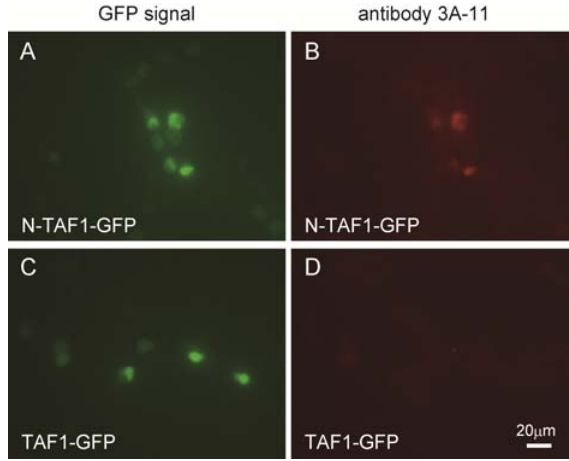
Figure 1. Immunocytochemistry of cultured Human embryonic kidney cells (HEK293) that express mouse neuron-specific TATA-binding protein-associated factor 1 (mN-TAF1) tagged with green fluorescent protein (GFP) ( A , B ) or mTAF1-GFP ( C , D ), using the monoclonal antibody, 3A-11F. Scale bar = 20 µm.